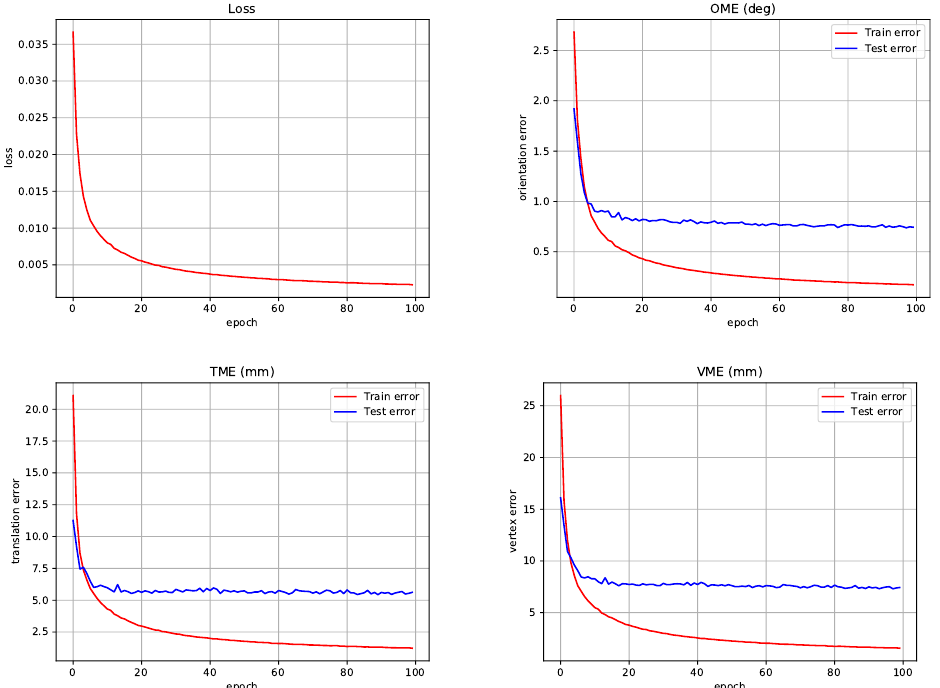
Figure 5. Curves for our loss and errors in the training